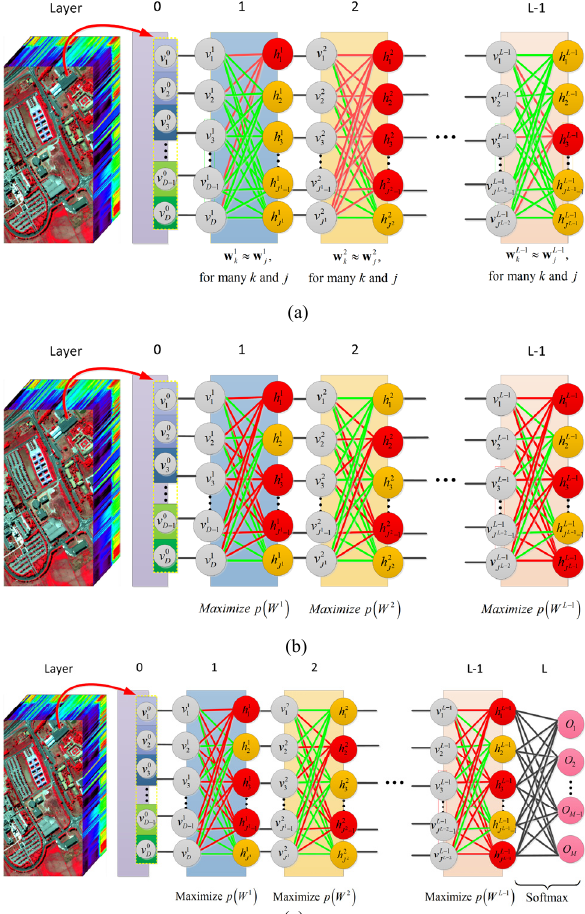
(c) Fig. 1. Illustration of graph structure of DBN (a), diversified DBN in the unsupervised pre-training procedure (b) and supervised fine-tuning procedure (c). The binary latent variables are considered in this illustration. The nodes with yellow and red color mean that the latent variables have value 0 and 1